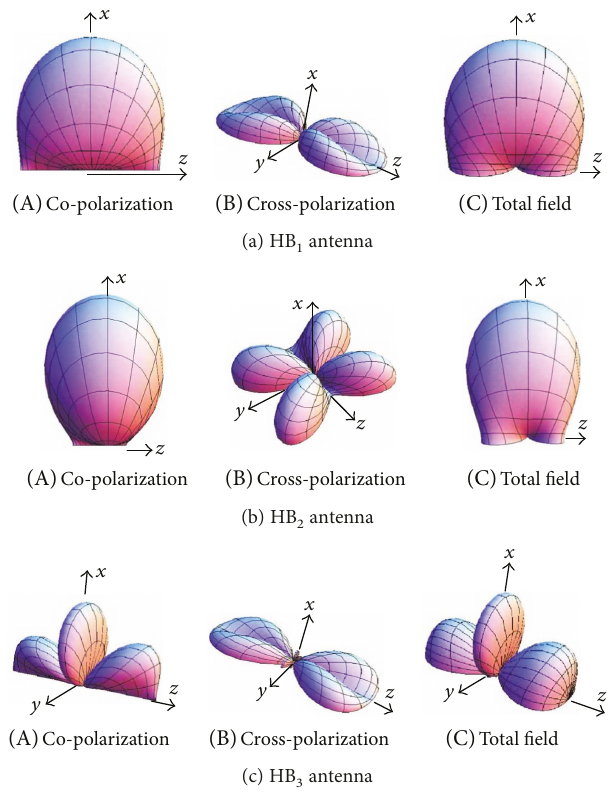
Figure 9: 3D radiation patterns of HB